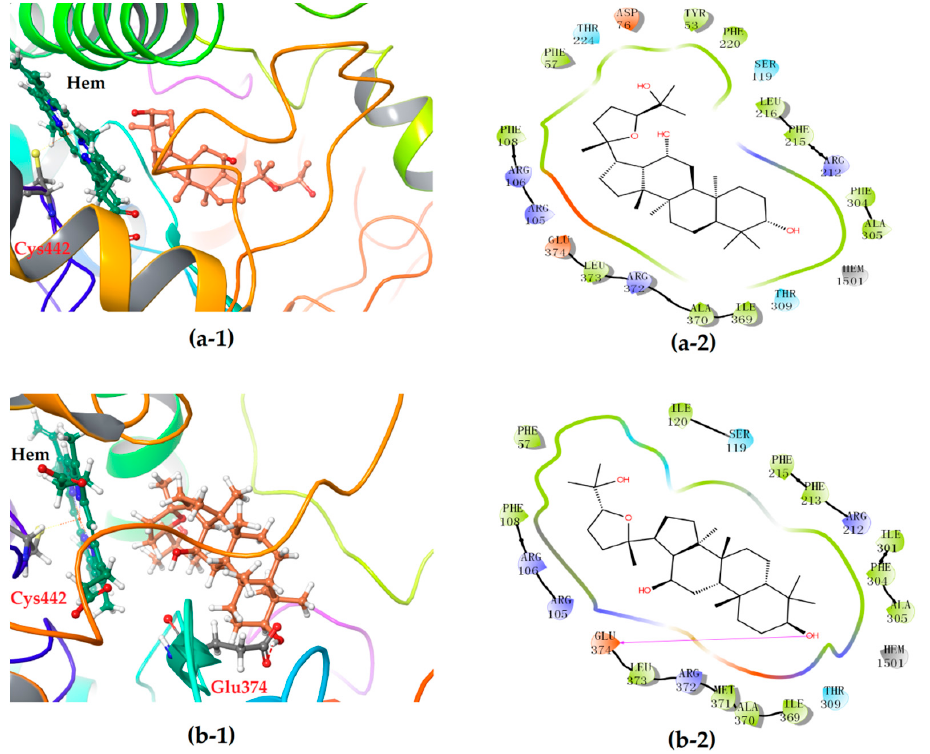
Figure 6. 3-D ( 1 ) and 2-D ( 2 ) diagrams illustrating the molecular interaction of 24 S -PDQ ( a ) and 24 R -epimer ( b ) with the CYP3A4. ( 1 ) The ball-stick structure: PDQ; the cartoon stucture: CYP3A4. ( 2 ) Purple arrow: hydrogen bond; red: charged (negative); purple: charged (positive); white: glycine; green: hydrophobic; blue: polar.